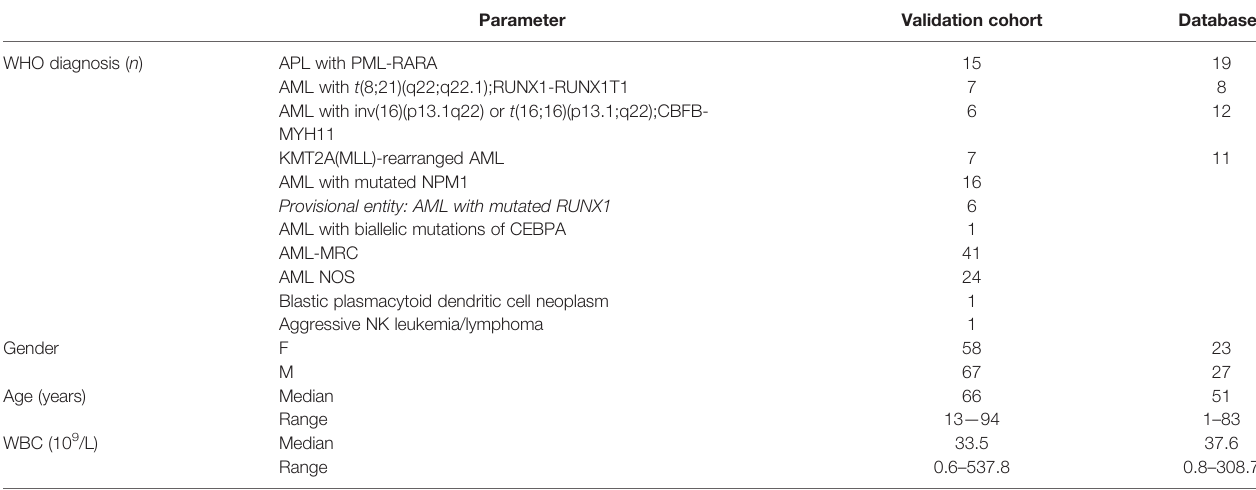
TABLE 1 | Characteristics of patients used for evaluation of the database-guided